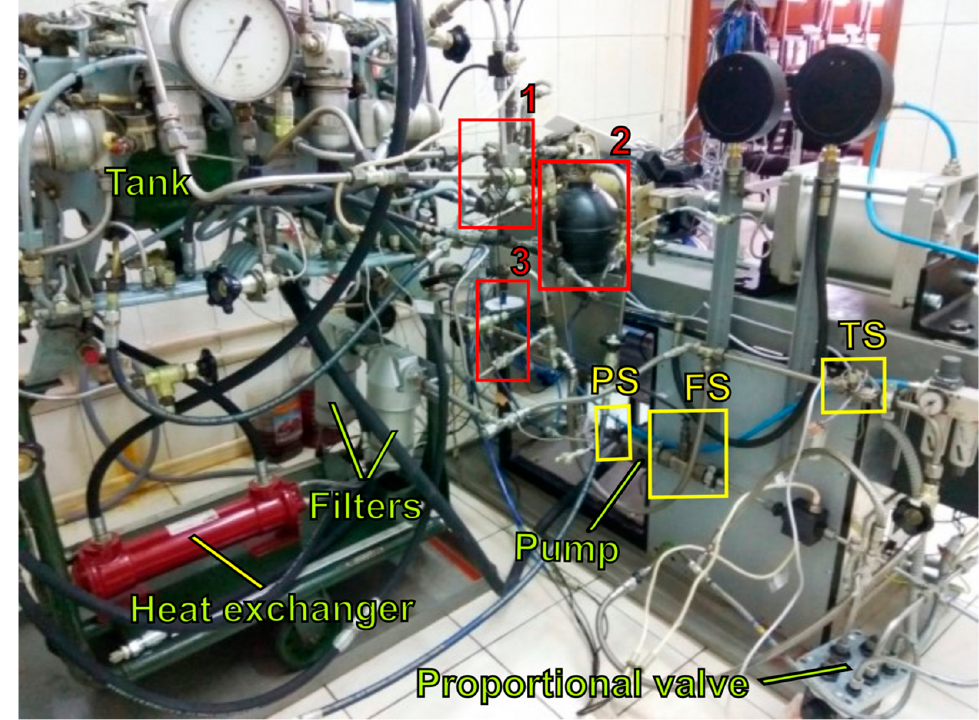
Figure 3. Our bench: 1—subsystem for HPA gas leakage; 2—subsystem for fluid leakage; 3—subsystem for the valve setting fault; PS—pressure sensor; FS—flow sensor; TS—temperature sensor.